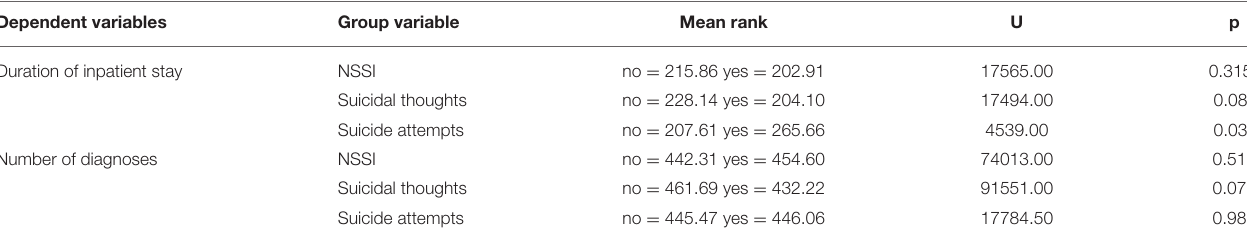
TABLE 4 | Group differences in the duration of inpatient stay and number of psychiatric diagnoses for the different reasons of emergency presentations (Results of Mann-Whitney U -tests for dependent variables). Dependent